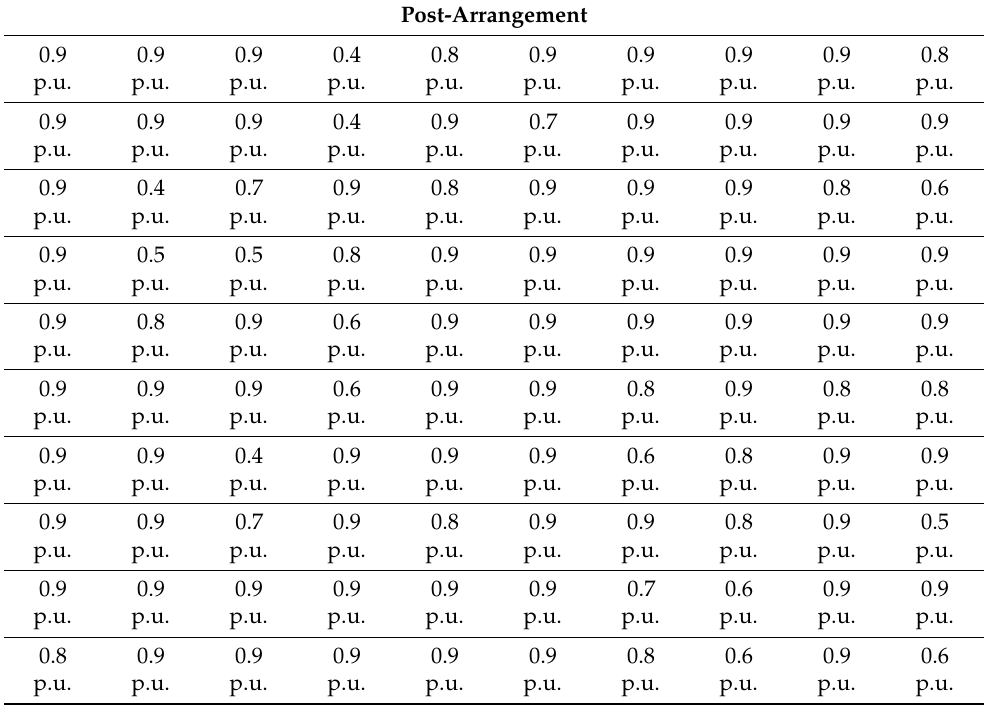
Table 3. PV array 10 × 10 parameters after